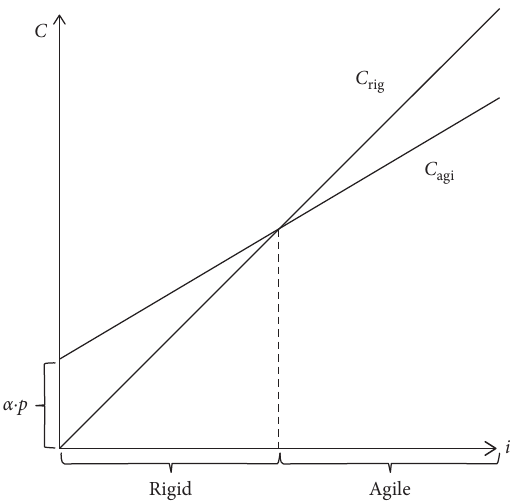
Figure 6: Analogy of the final fees of adamant with agile SCs.